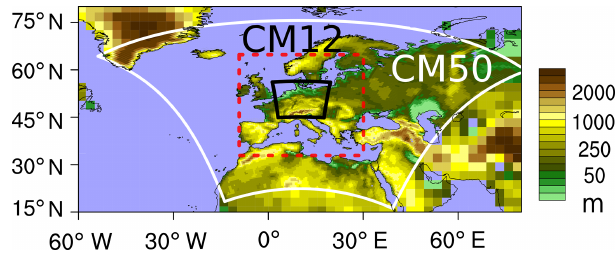
Figure 1. Domains of CM50 (white line) and CM12 (black line). Depicted is the topography of the continents (in metres) at the reso- lution of the corresponding model instance. Outside the CM50 do- main the topography of EMAC is displayed. Shown is the entire computational domain including the relaxation area. The dashed red square indicates the region analysed in Sect. 4. The figure is repro- duced from Mertens